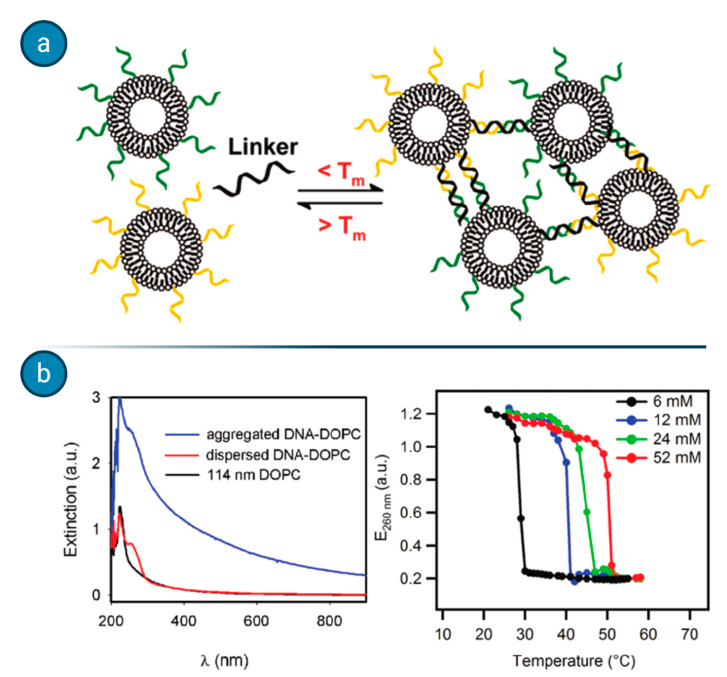
Figure 9. Single-stranded DNA-mediated liposome aggregation assay. ( a ) In the presence of a target nucleic acid (below the respective melting temperature, T m ), liposomes bearing specific probes on their surfaces are able to interact with the analyte and form clusters. ( b ) Cluster presence is then determined spectrophotometrically. Figure adapted with permission from [62]. Copyright 2011 American Chemical Society.